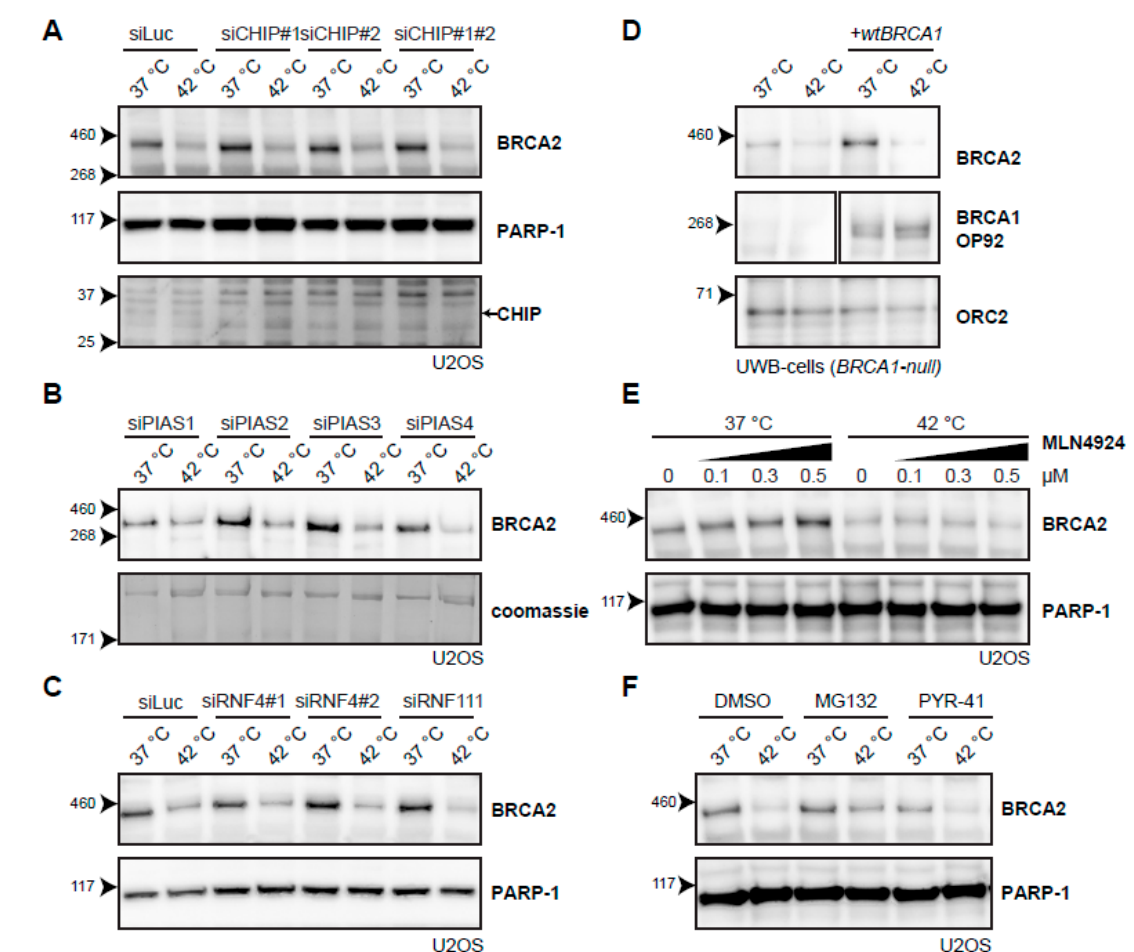
Figure 5. Searching for the E3-ligase that mediates degradation of BRCA2 upon hyperthermia. ( A ) E ff ect of hyperthermia on BRCA2 levels upon knock-down of the Heat-shock Protein (HSP)-associated E3-ligase, C terminus of HSC70-Interacting Protein (CHIP), in U2OS cells using two di ff erent siRNAs. Arrow on the right next to the CHIP panel indicates the predicted position of the CHIP protein. ( B ) E ff ect of hyperthermia on BRCA2 levels upon knock-down of the SUMO-E3 ligases Protein Inhibitor Of Activated STAT( PIAS) 1-4 in U2OS cells using siRNAs. ( C ) E ff ect of hyperthermia on BRCA2 levels upon siRNA knock-down of DNA-repair-related, SUMO-targeted ubiquitin ligases, Ring Finger (RNF) 4 and RNF111. ( D ) Detection of BRCA2 and BRCA1 in UWB1.289 (BRCA1-null) cells